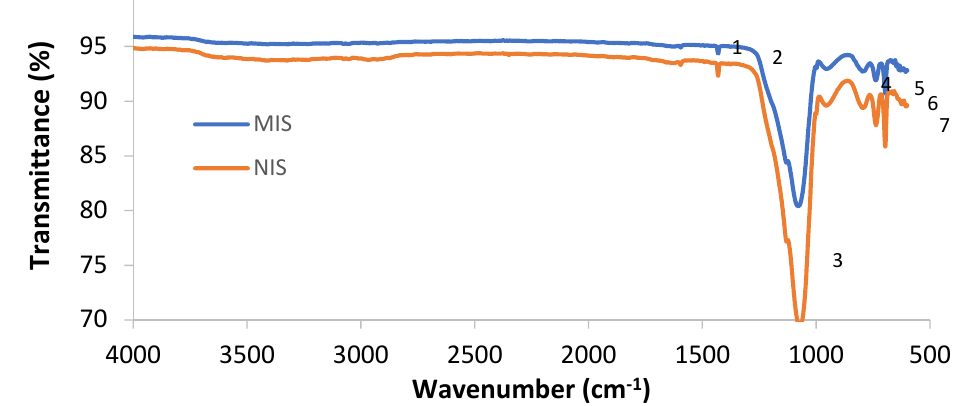
Figure 3. Infrared spectra of MIS4 and NIS4. Absorption assignements: (1) 1597 cm − 1 (C=C) aromatic, (2) 1431 cm − 1 (Si-phenyl), (3) 1075 cm − 1 (Si-O-Si), (4) 950 cm − 1 (Si-O - ), (5) 790 cm − 1 (Si-O-Si), (6) 738 cm − 1 (Si-phenyl), (7) 698 cm − 1 (Si-phenyl).